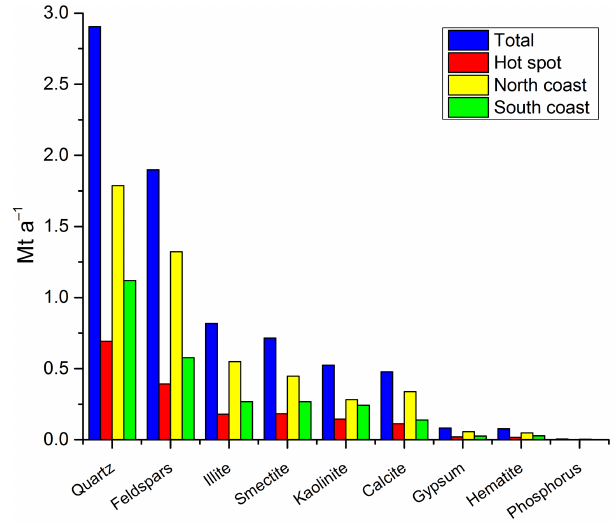
Figure 9. Annual mineral emission fluxes (Mta − 1 ) in 1kmALL ex- periment with SEVIRI source function